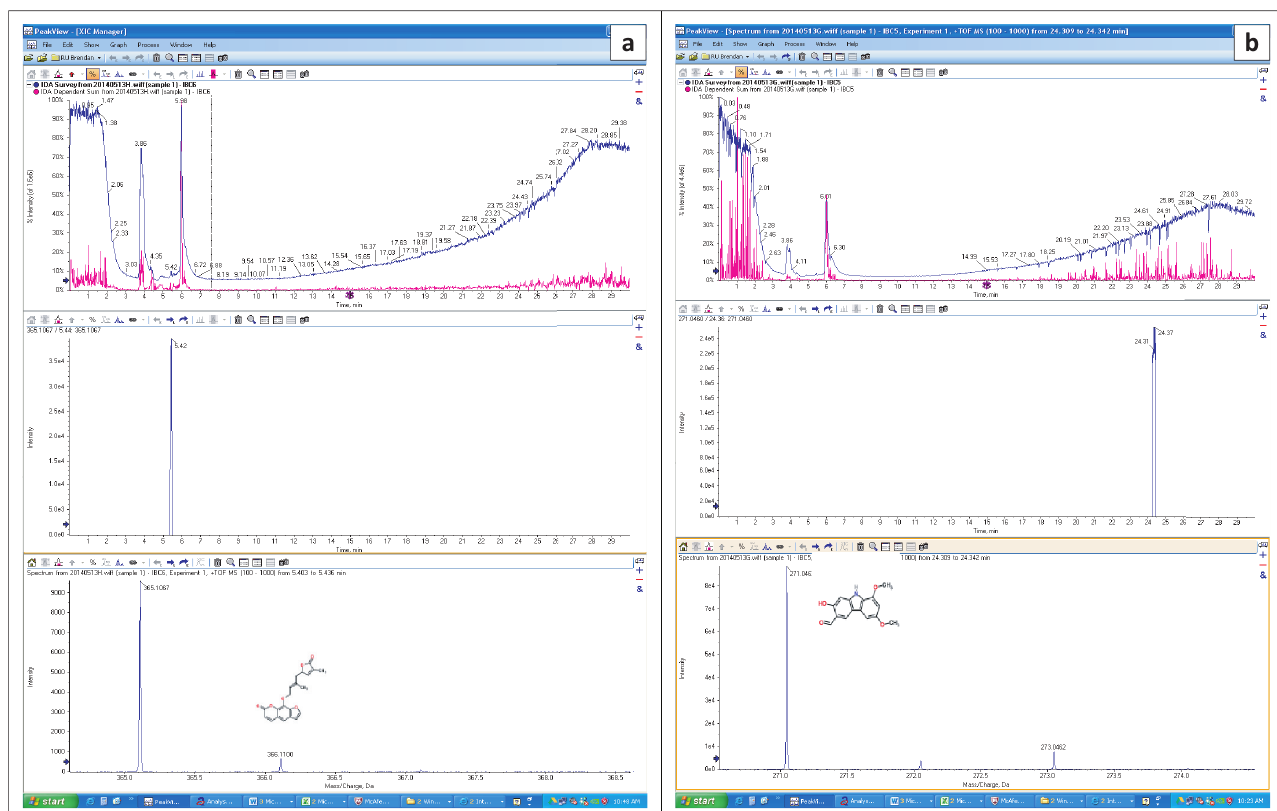
FIGURE 8: Liquid chromatography–mass spectroscopy chromatogram of quercetin 3,4-dimethyl ether and α